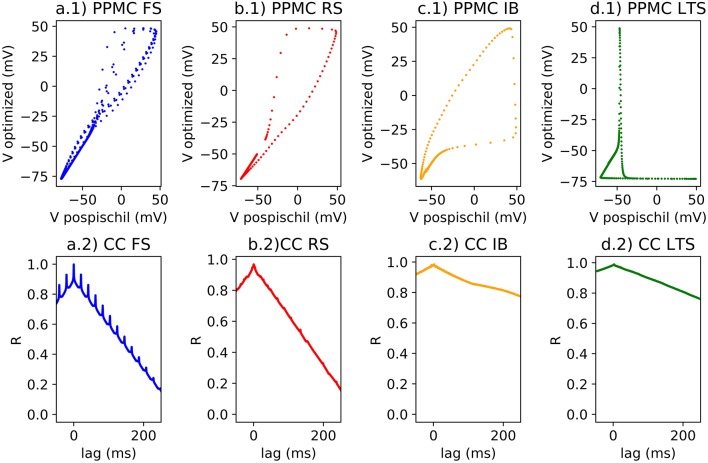
(1) Single spike on scatter plot for the Pearson Correlation calcul; (2) Lag and R coefficient represented for each classes of neurons; (a) FS neuron with a stimulation of 0.5 nA, rPPMC = 0.96 for a single spike and for a spike train, rCC = 0.99; (b) RS neuron with a stimulation of 0.75 nA, rPPMC = 0.96 for a single spike, rPPMC = 0.37 for a spike train, rCC = 0.97; (c) IB neuron with a stimulation of 0.15 nA, rPPMC = 0.89 for a single spike, rPPMC = 0.34 for a burst, rPPMC = 0.38 for a spike train, rCC = 0.97; (d) LTS neuron with a stimulation of −0.15 nA, then no stimulation, then 0.15 nA of stimulation, rPPMC = 0.38 for a single spike, rPPMC = 0.34 for a burst, rPPMC = 0.38 for a spike train, rCC = 0.97.